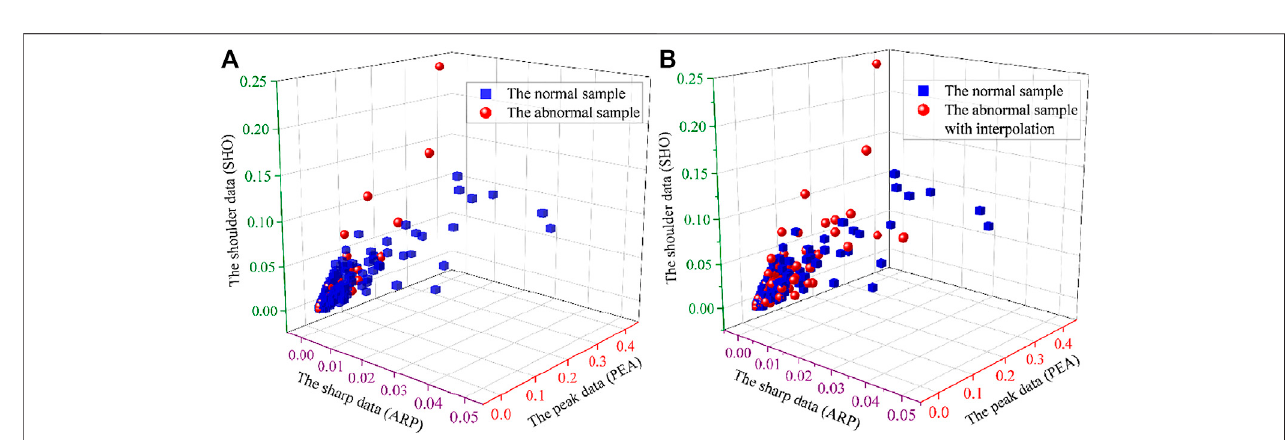
FIGURE 4 | Distribution of the power consumption user samples (panel (A) is for the original 929 samples, and panel (B) is for the SMOTE-balanced output of the 1,151 samples).